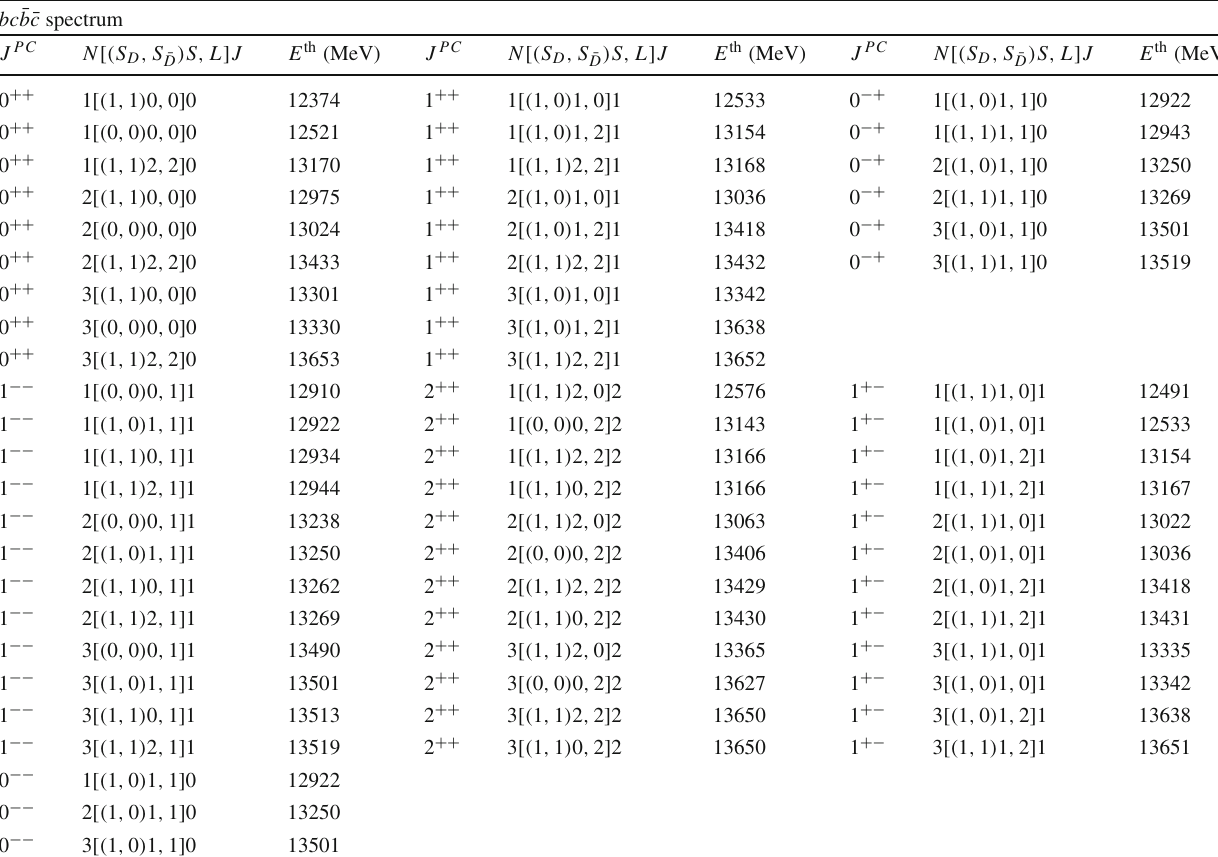
Table 4 As Table 3, but for bc ¯ b ¯ c states